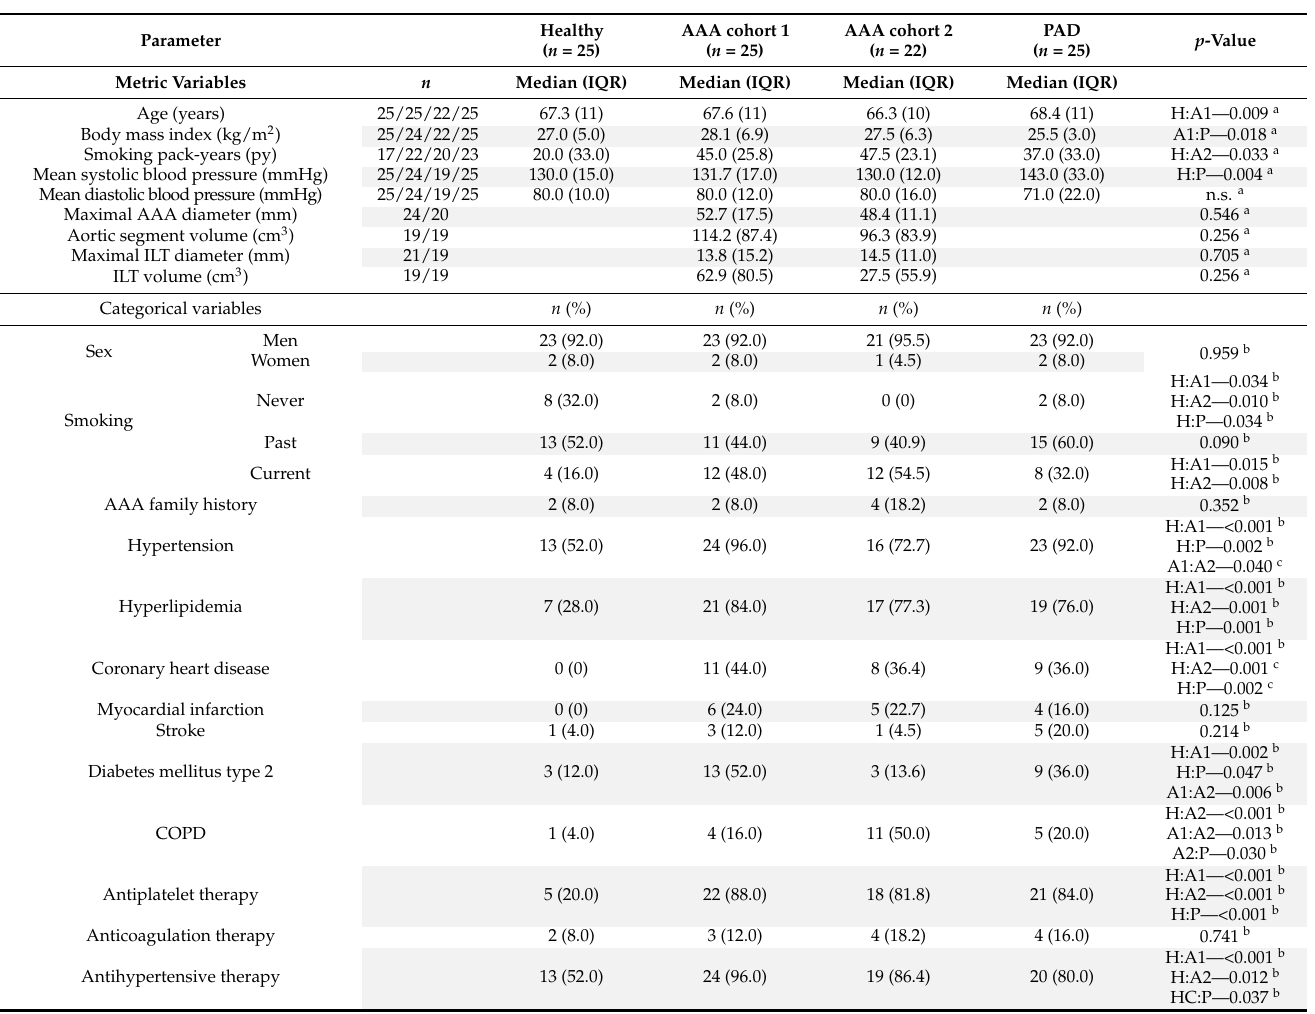
Table 1. Demographics of AAA patients and control groups in the diagnostic